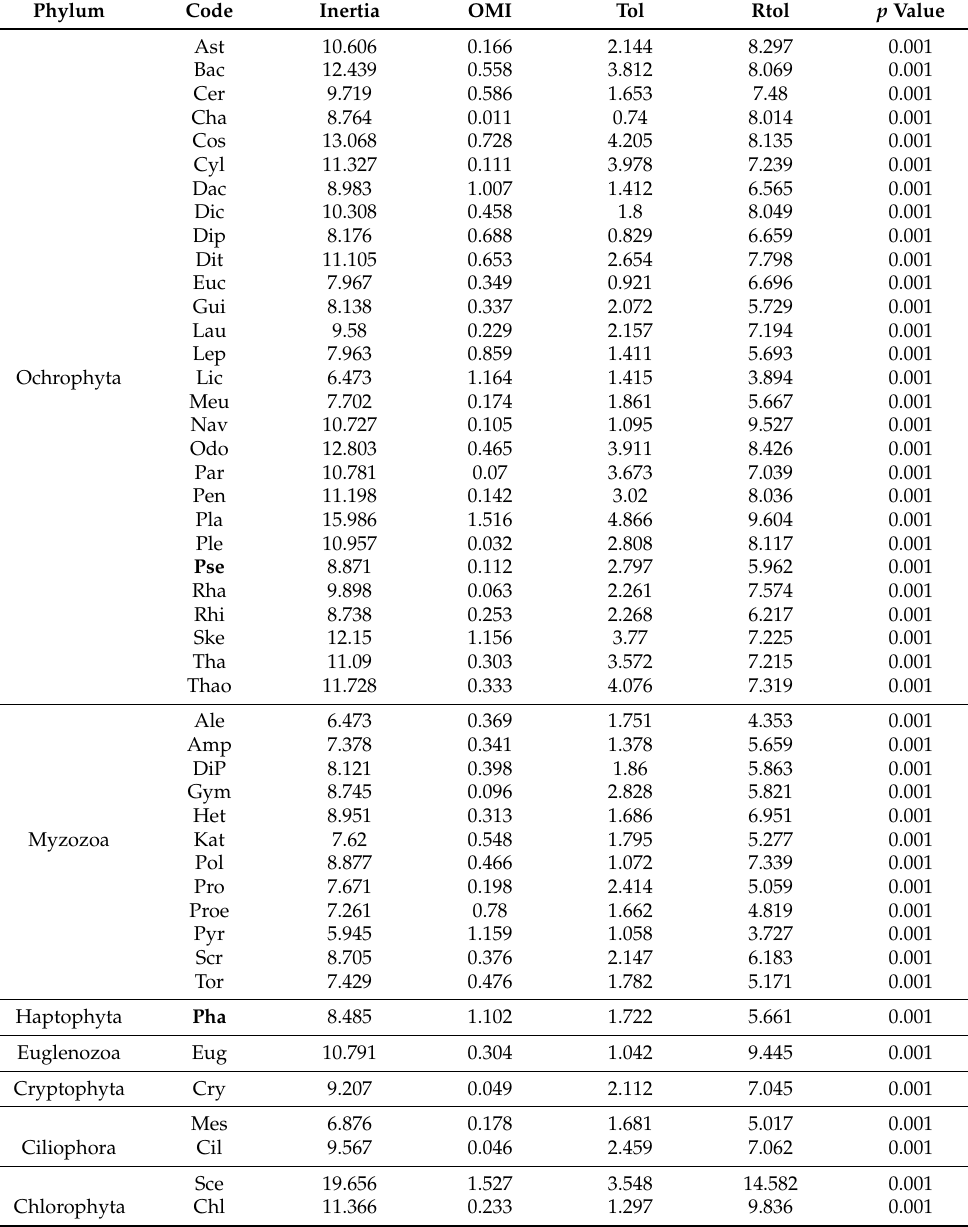
Table 3. Niche parameters calculated with the OMI analysis for 47 taxa including Phaeocystis glo- bosa (Pha) and the complex Pseudo-nitzschia spp (Pse) found in bold. The parameters are Inertia, marginality (OMI), the tolerance (Tol) and residual tolerance (Rtol). The p values were calculated with 1000 permutations; see methods for further